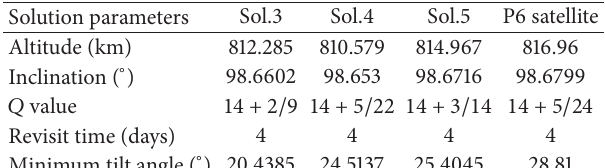
Table 8: Parameters and characteristics of some orbit solutions within RT des = 4 .